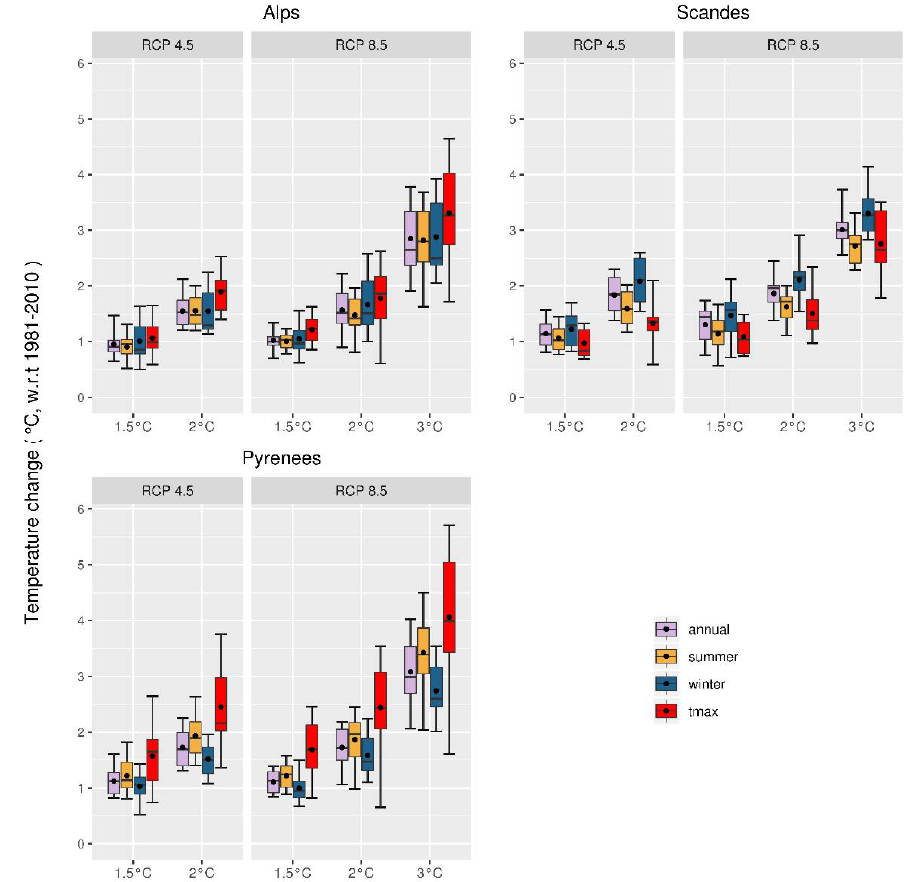
Figure A1. Projected temperature change (°C) in the alpine tundra domain (ATD) across scenarios relative to the reference period (1981–2010) in three regions. Results are shown for the 11 RCM simulations for RCP4.5 and RCP8.5 in three warming levels. Summer (orange): temperature of the summer half of the year; annual (purple): annual temperature; winter (blue): temperature of the winter half of the year; tmax (red): temperature of the warmest month of the year. The median (horizontal line in boxes), mean (black circle in boxes), 25–75% range (boxes), and minimum to maximum range (whiskers) across the 11 simulations are shown for each scenario, period and season. Note that the 3 °C period was computed only in RCP8.5.